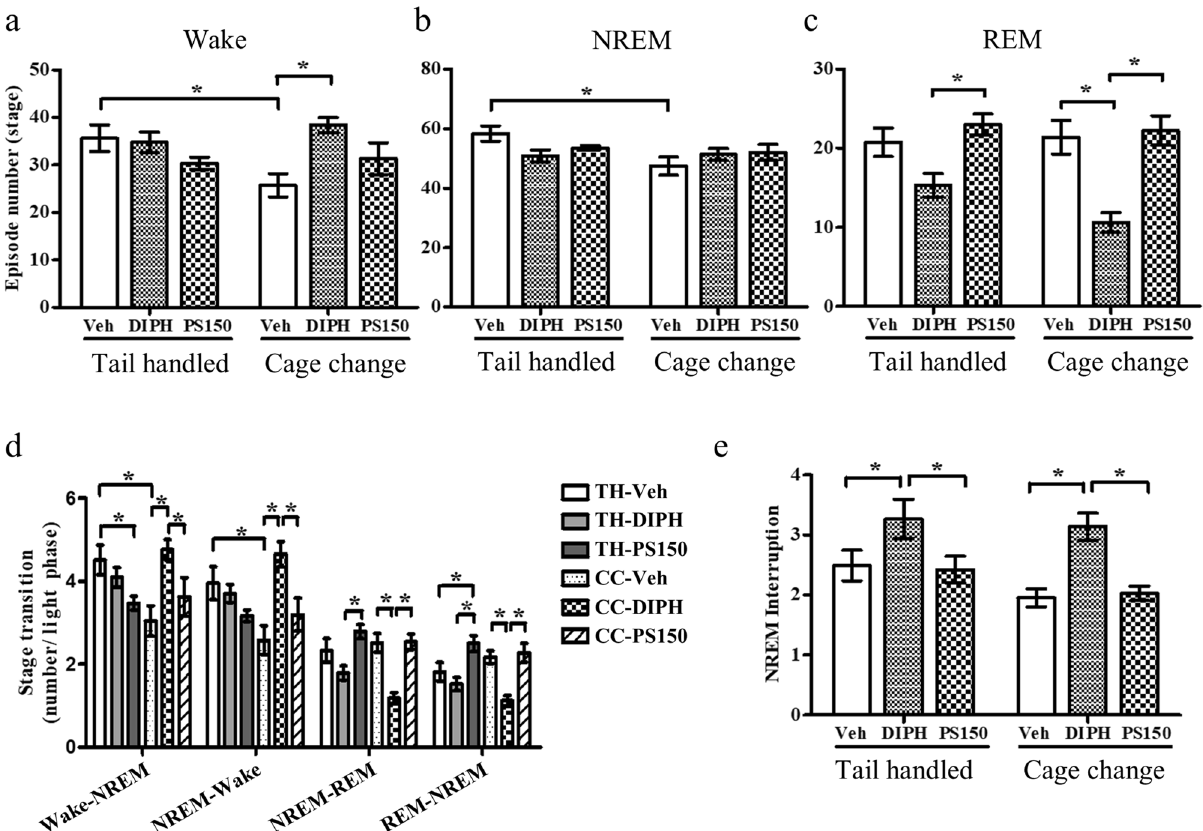
Figure 3. Total number of vigilance and sleep states during the light phase. (a–c) The total number of wakefulness, non-rapid eye movement (NREM), and REM states. (d) The average number of transitions per hour between each state. (e) The total number of NREM sleep interruptions observed. Data are expressed as the mean ± SEM ( n = 7–9) and were analyzed by two-way ANOVA with Bonferroni correction (* p <